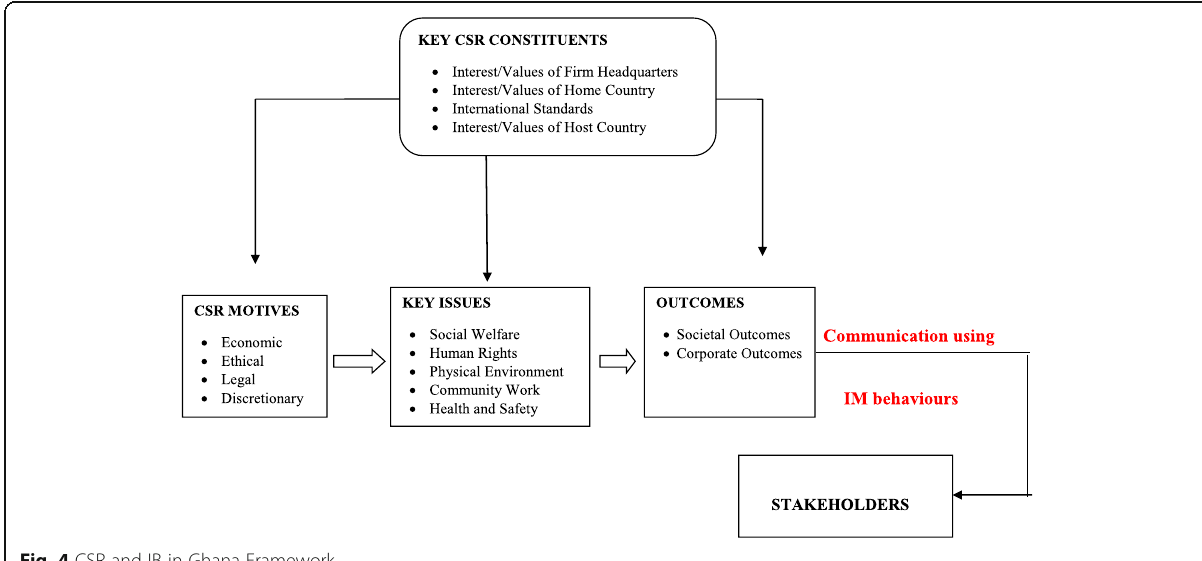
Fig. 4 CSR and IB in Ghana